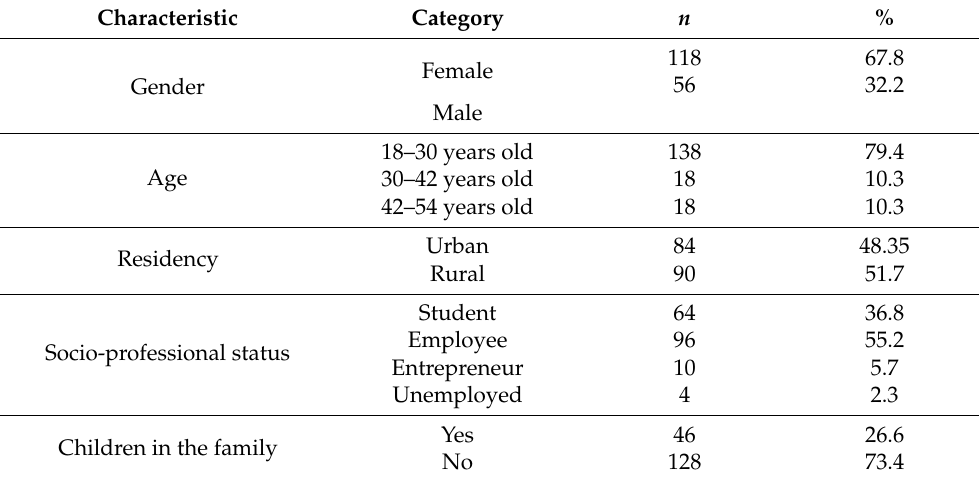
Table 2. Socio-demographic characteristics of respondents.